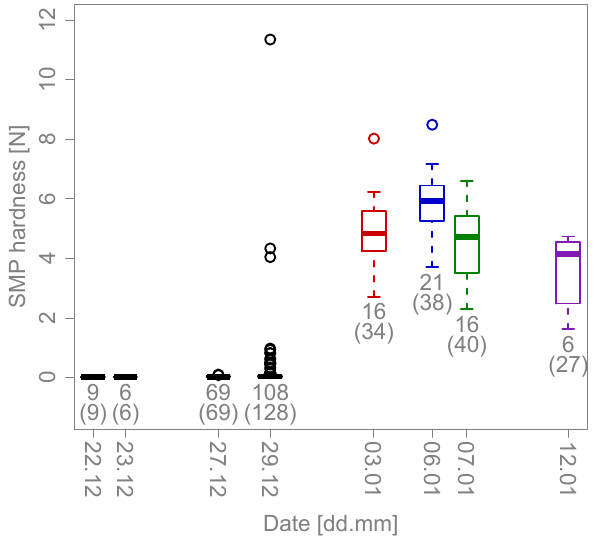
Figure 6. Time evolution of the SMP hardness for all SMP mea- surements with snow at the surface that was deposited during or af- ter the snowfall period. The numbers below each box plot indicate for each day how many SMP measurements were acquired in such deposition areas. The numbers in parentheses indicate how many SMP measurements were acquired in total on each day. The boxes show the first and third quartiles and the length of the whiskers is 1.5 times the interquartile range at most. The SMP measurements acquired after the main drifting snow event are color coded based on when they were acquired. These colors are used again in Figs. 10, 11 and